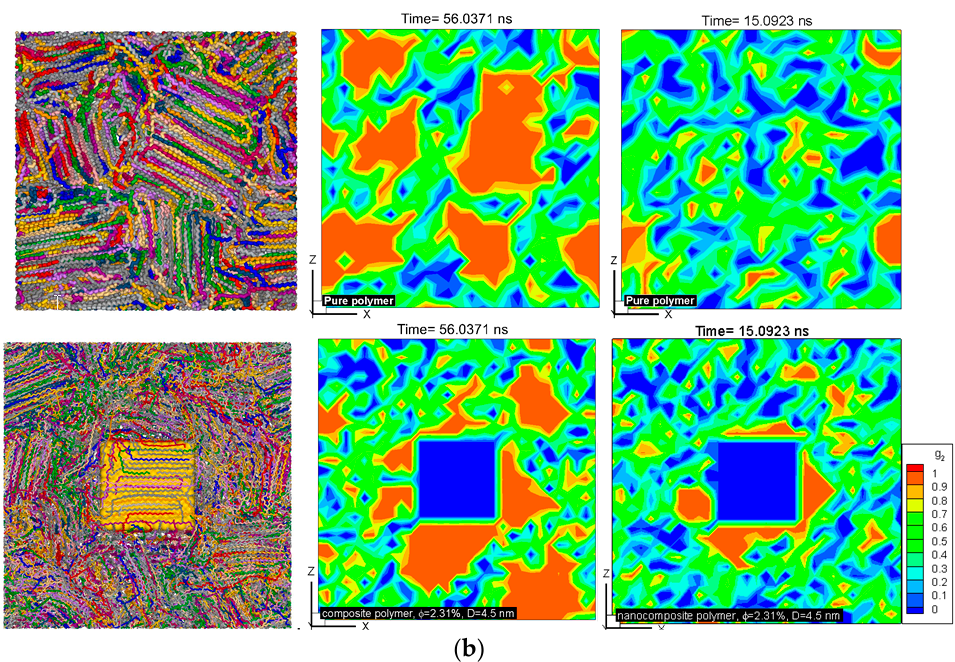
Figure 2. ( a ) The same as in Figure 1a, shown for nanocomposite systems of the same cubic additive particle size ( D = 4.5 nm) and different volume fractions (solid lines of various thickness proportional to the volume fraction of additives). ( b ) Sliced contours of local crystallinity for pure (top row) and nanocomposite (bottom row, D = 4.5 nm, φ = 2.31%) polymers at the center of the simulation box are shown at ~15 ns (enhanced crystallization with nanoparticle additive) and ~56 ns (lower crystallization with nanoparticle additive). The red (color online) regions have more than 90% crystallinity (see also movies in the supporting material showing the slices across the simulation domain). The sliced snapshots show corresponding molecular orientations for pure and composite polymers at the end of crystallization (molecules are shown by different colors for clarity) (see also movies in the supporting material showing crystallization of molecules for the pure and nanocomposite polymers).